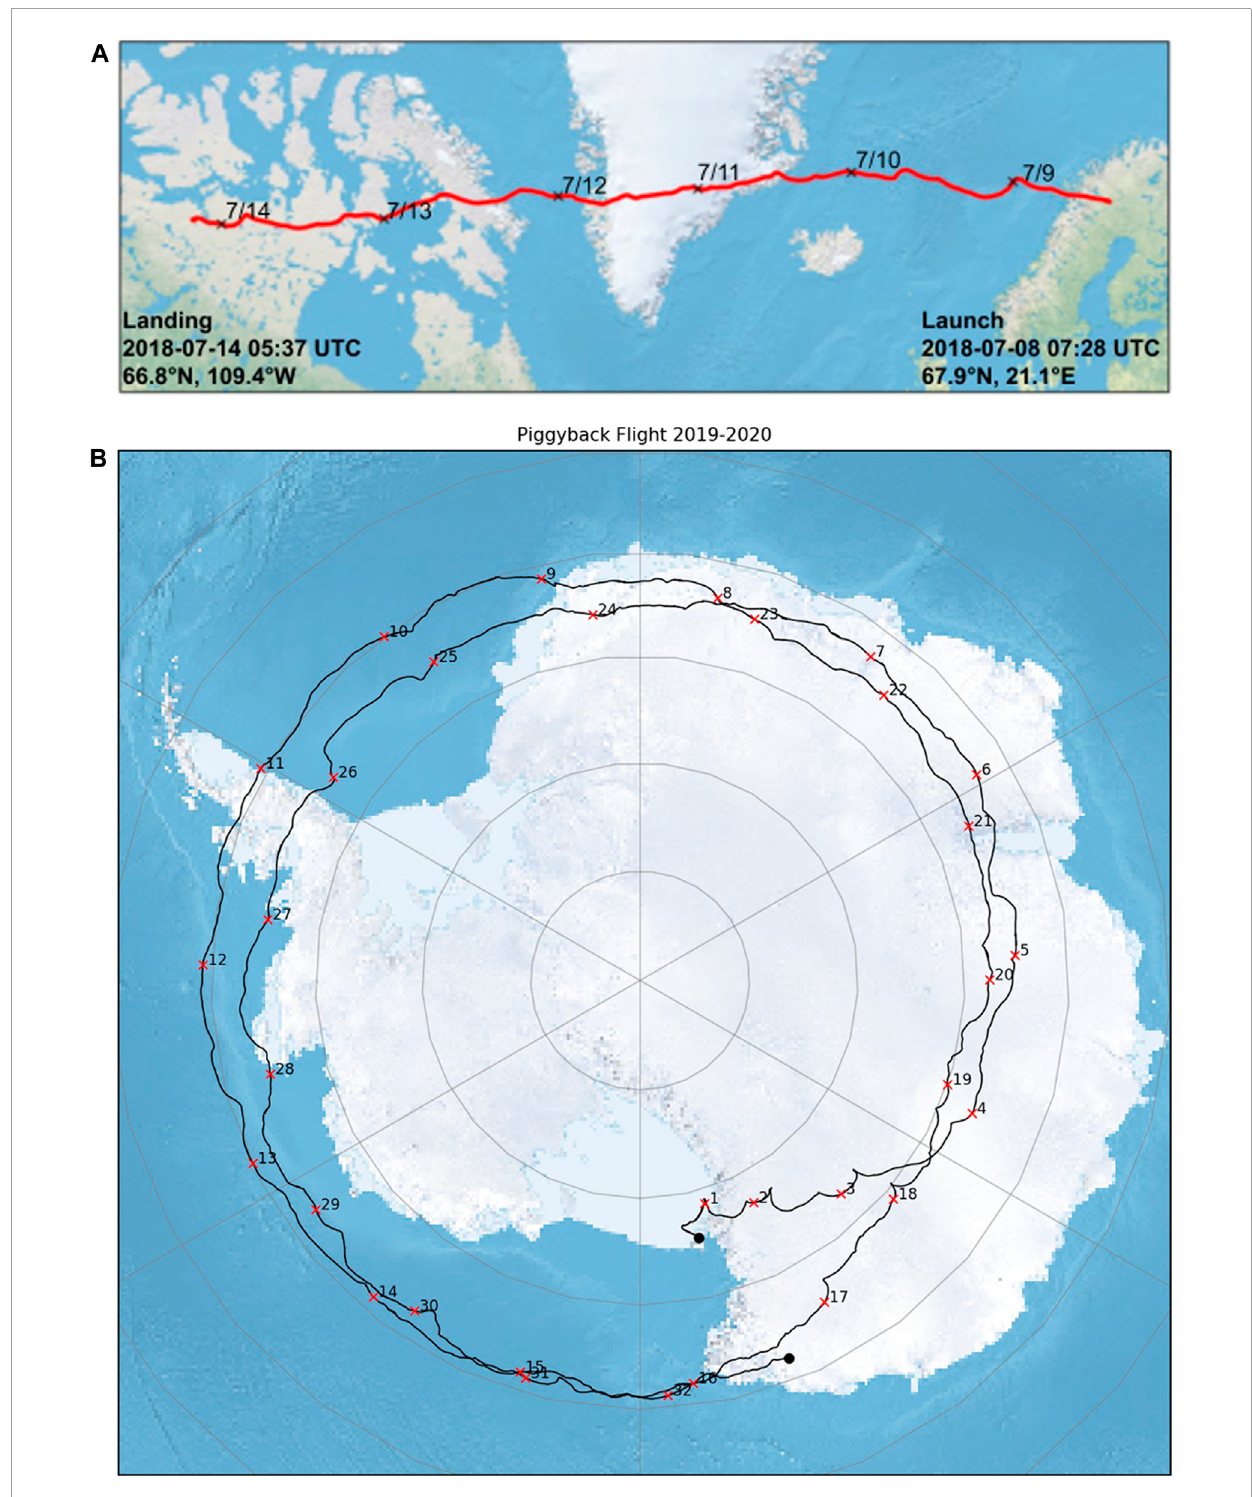
FIGURE 5 PMC-Turbo flight trajectories using SkyWinder flight control software. (A) The PMC-Turbo flight trajectory from Kjellstrand (2021). (B) Piggyback flight trajectory with marked days of flight from Kjellstrand (2021).